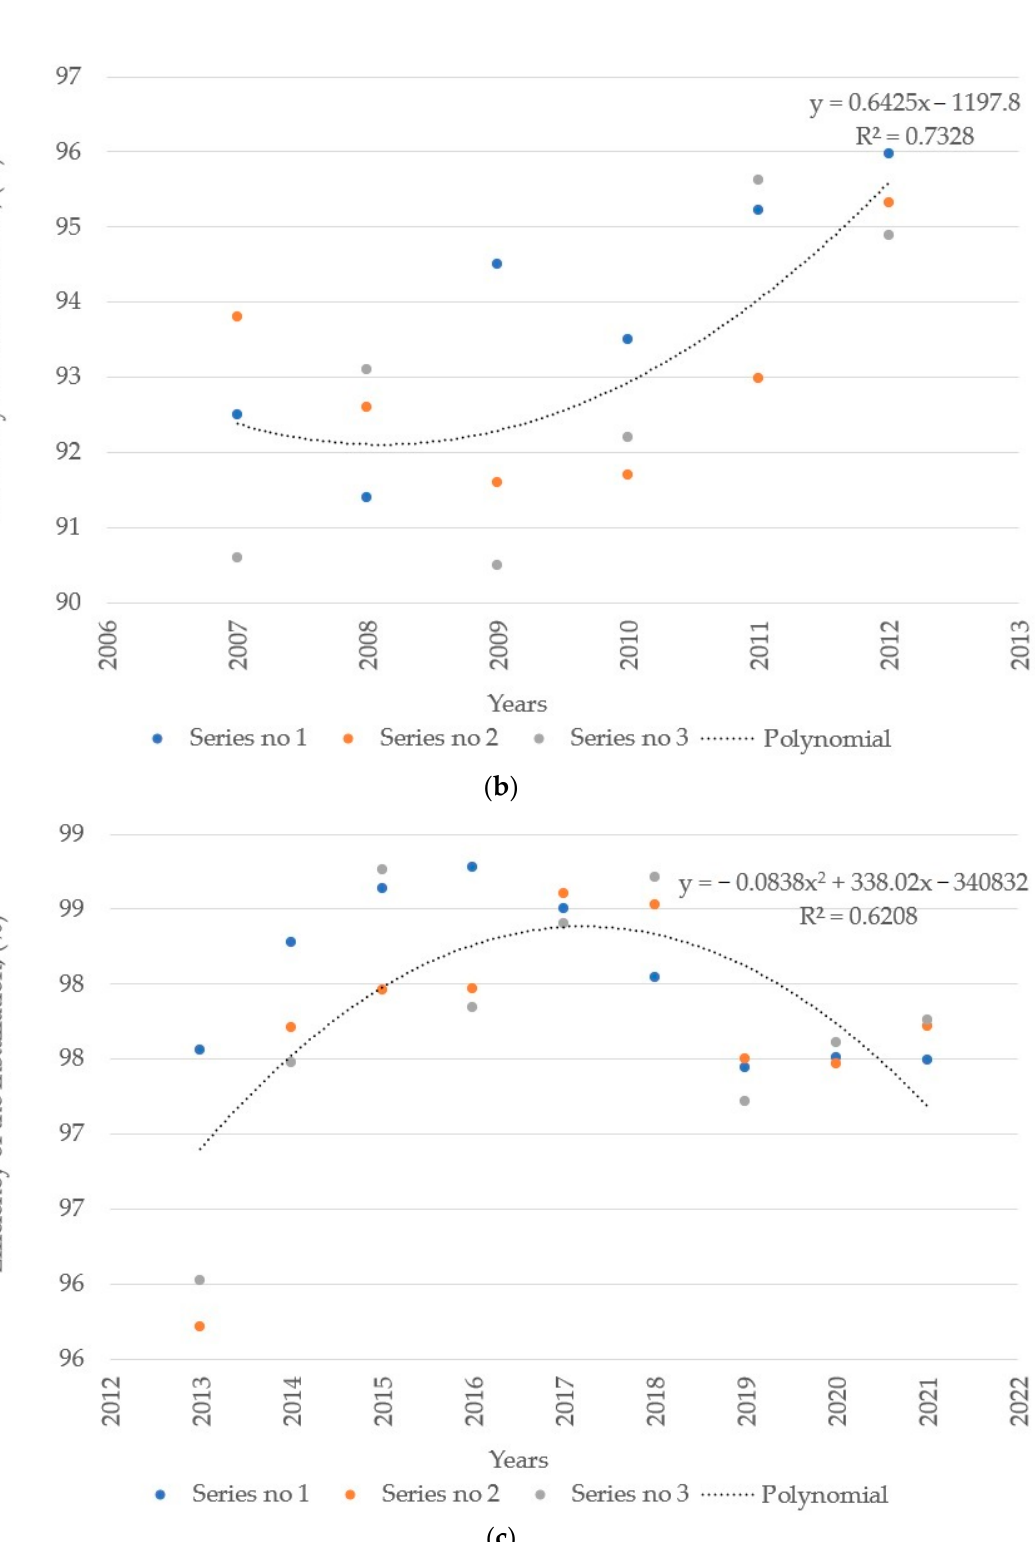
Figure 5. Efficiency of the dedusting installation in the Wieliczka Salt Mine in the years: ( a ) 2004–2006; ( b ) 2007–2012; ( c ) 2013–2021.